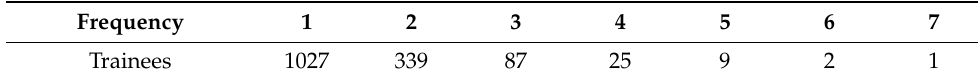
Table 1. Frequency table of how many times each trainee took the